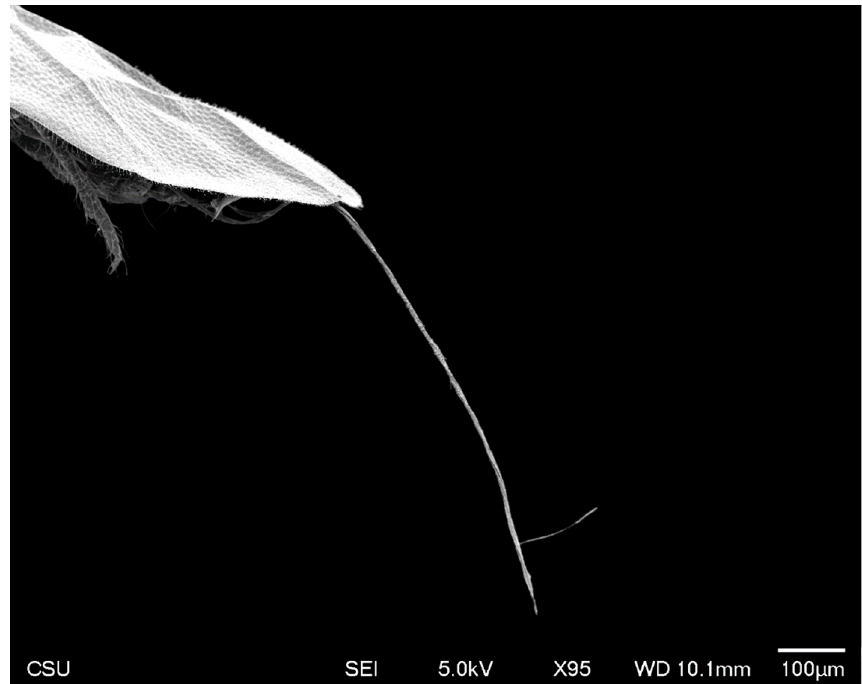
Figure 9. SEM showing the full length of one seta of the glandular pouch of the male A. galliformis .